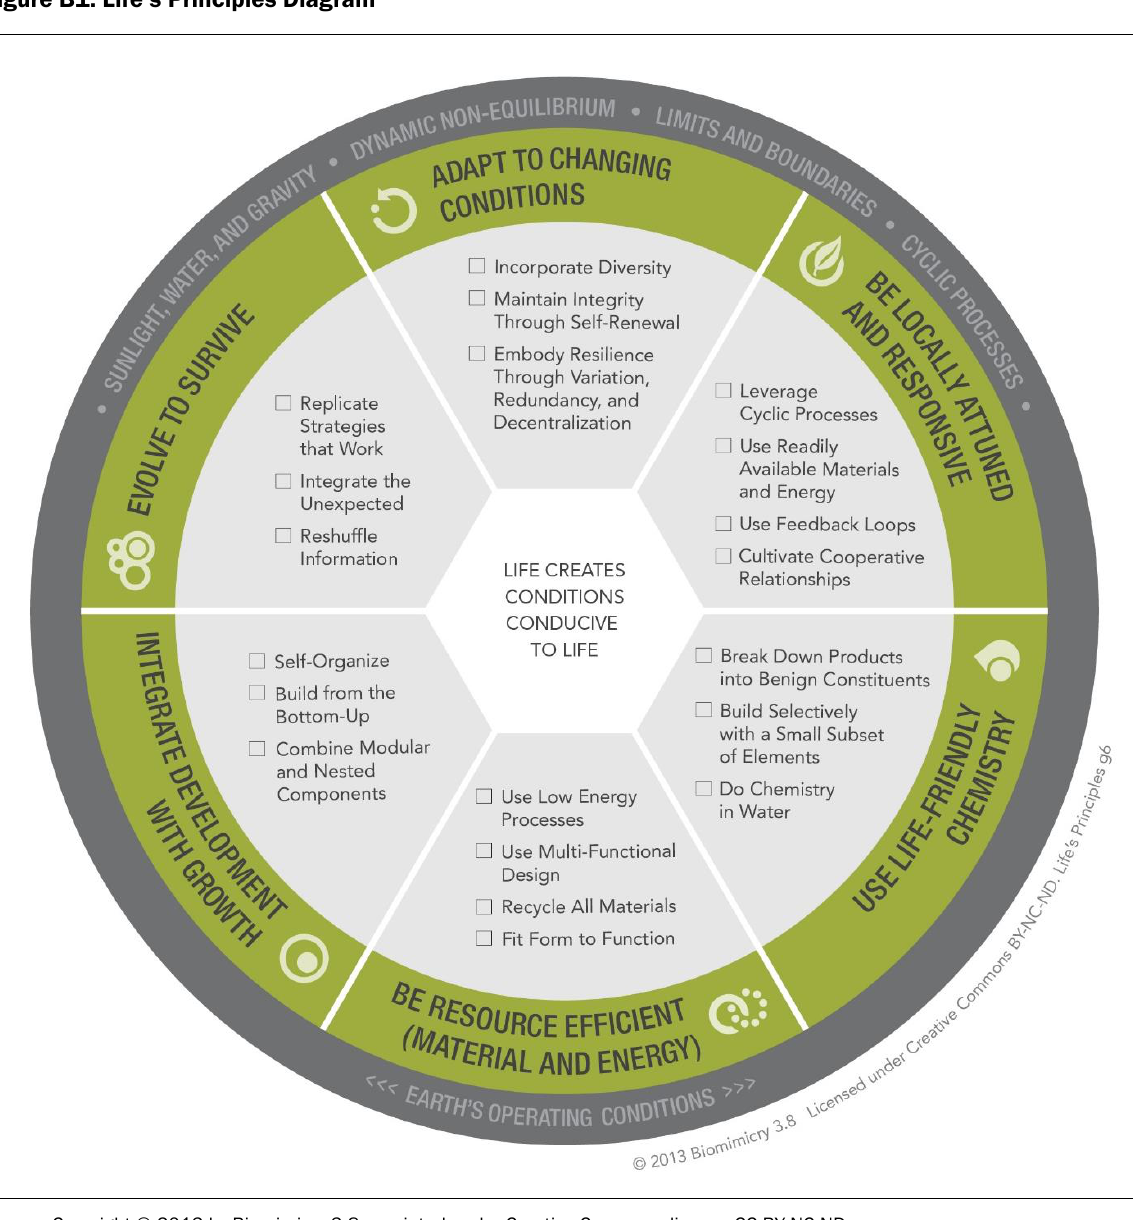
Figure B1. Life ’s Principles